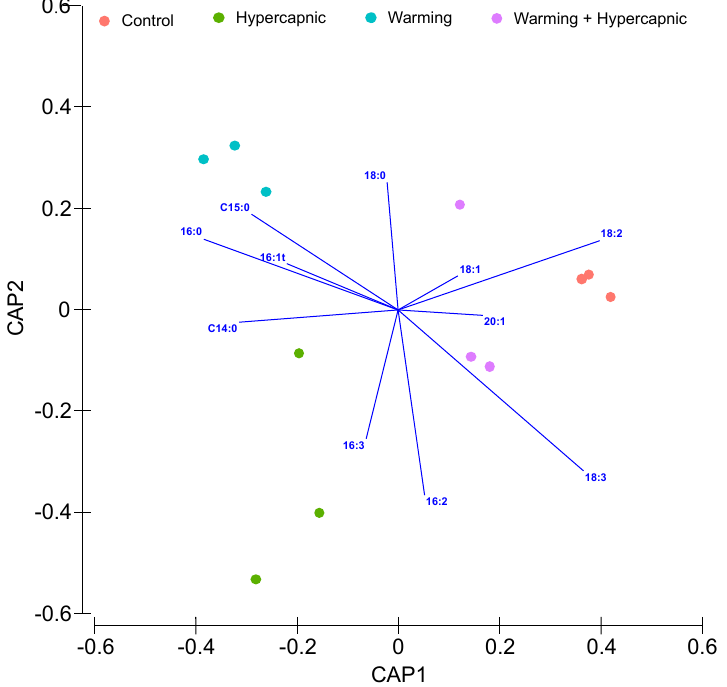
Figure 2. Zostera noltii leaf total fatty acid canonical analysis of principal (CAP) components of the samples exposed to control, hypercapnic, warming and combined stress conditions ( n = 3 per treatment).